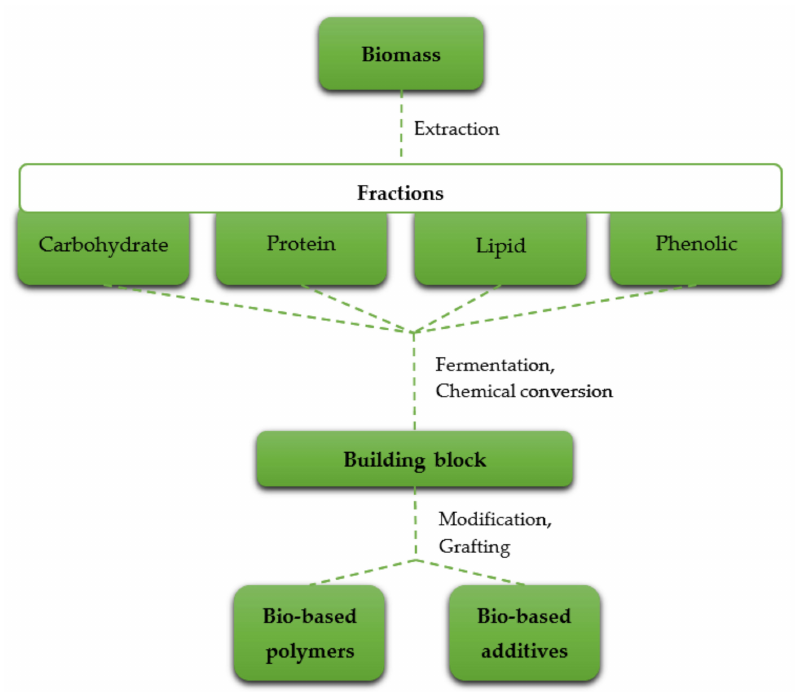
Figure 3. The conversion of biomass to bio-based polymers and additives [10].